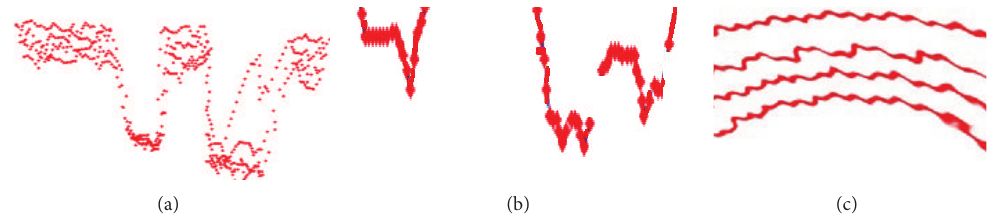
Figure 1: Projection of scan lines on the x - y plane.